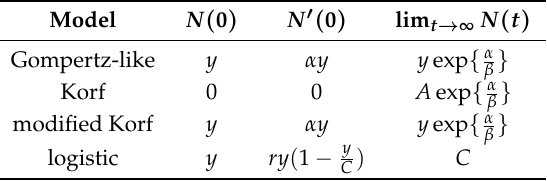
Table 2. Some characteristics of the growth